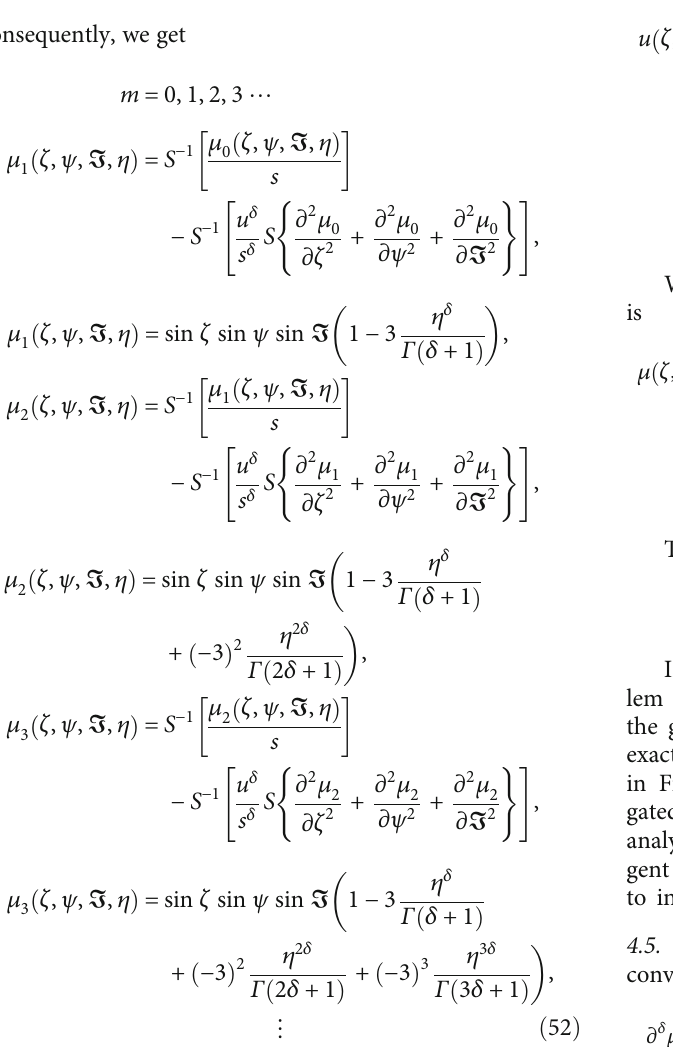
Figure 5: Graph of exact and approximate solutions of Problem